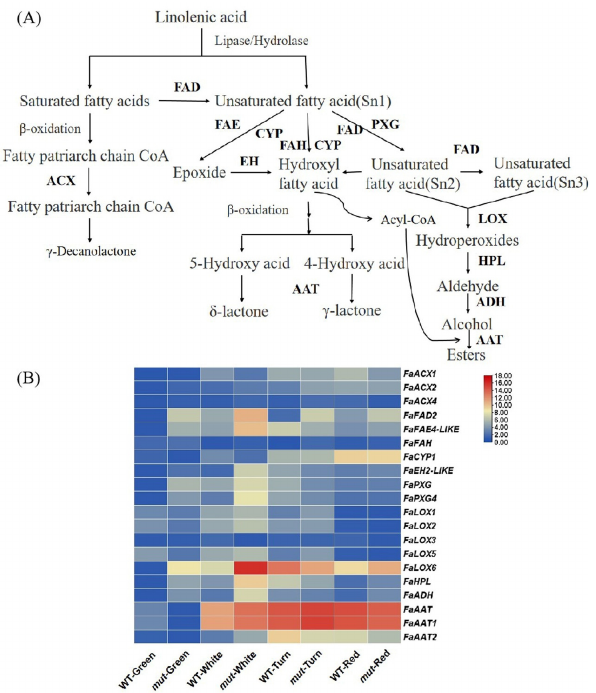
Figure 4. Fatty acid pathway analysis. ( A ) Schematic diagram of the fatty acid pathway. Multiple enzymatic reactions are illustrated by stacked arrows. Abbreviations: ACX: acyl-CoA oxidases;